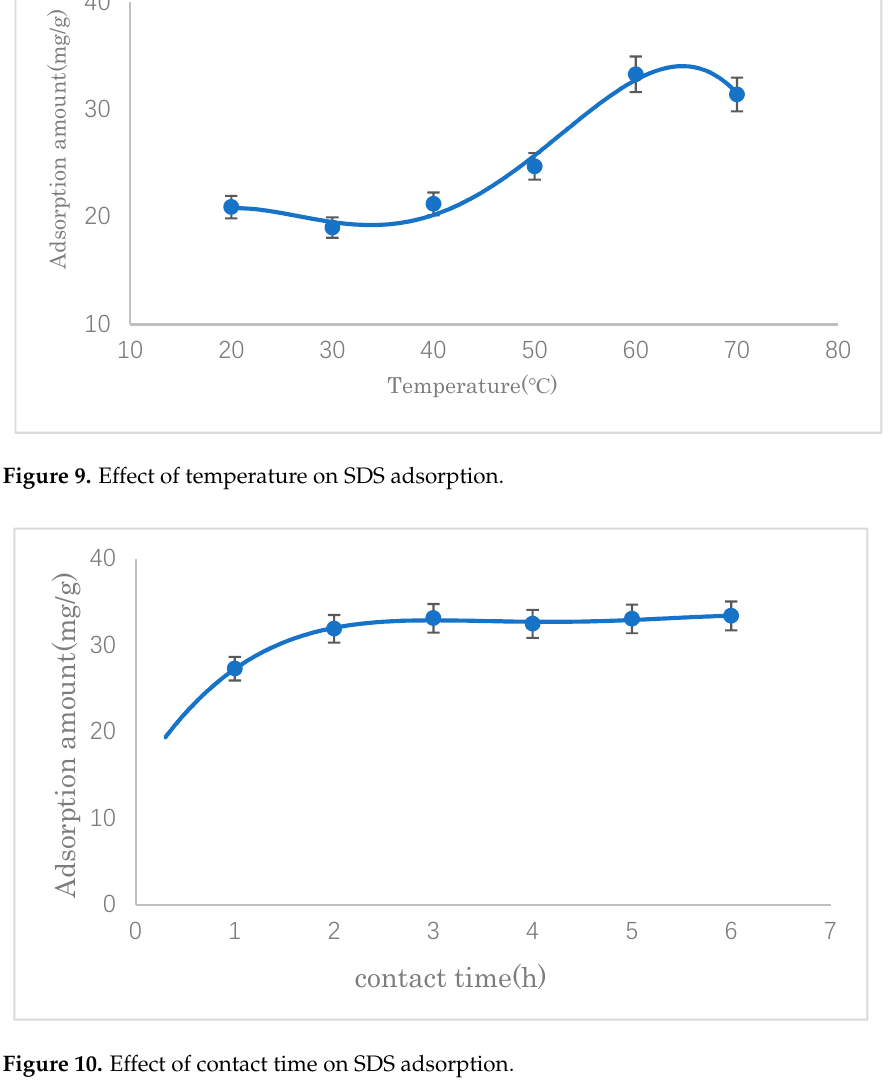
Figure 10. Effect of contact time on SDS adsorption.